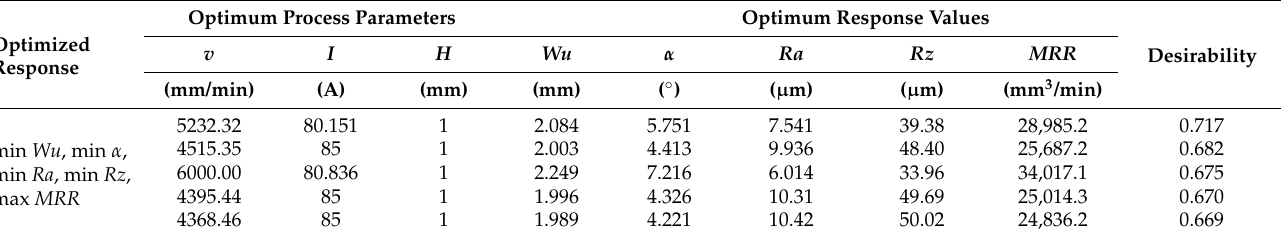
Table 11. Multi-objective optimization results.